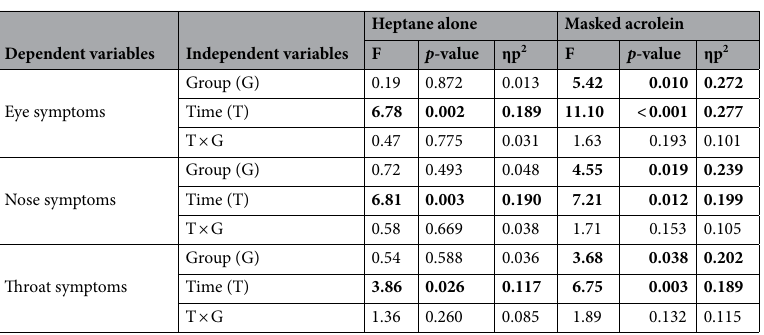
Table 5. Results from the two-way mixed ANOVAs with Time (16 measuring points) as the within-subjects variable and Group (referents/BRS cases/BRS + CI cases) as the between-subjects variable and reported symptoms as the dependent variables in the heptane alone and masked acrolein exposure conditions. Significant values are in